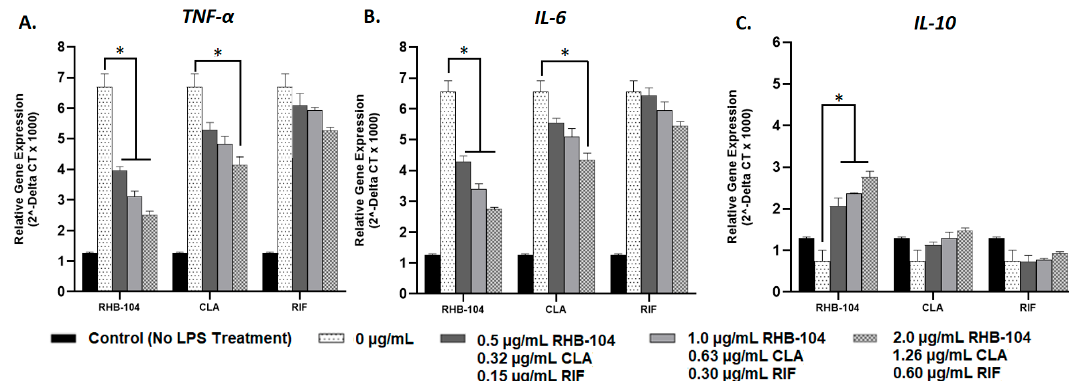
Figure 5. Effect of RHB-104 and its major components on TNF- α , IL-6 , and IL-10 expression in LPS-treated macrophages. RT-PCR measurements of expression of TNF- α ( A ), IL-6 ( B ), and IL-10 ( C ) in LPS-treated macrophages (24 h) followed by treatment with RHB-104 (0, 0.5, 1.0, 2.0 μ g/mL), CLA (0, 0.32, 0.63, and 1.26 μ g/mL), and RIF (0, 0.15, 0.30, 0.60 μ g/mL) for 24 h. * p < 0.05.